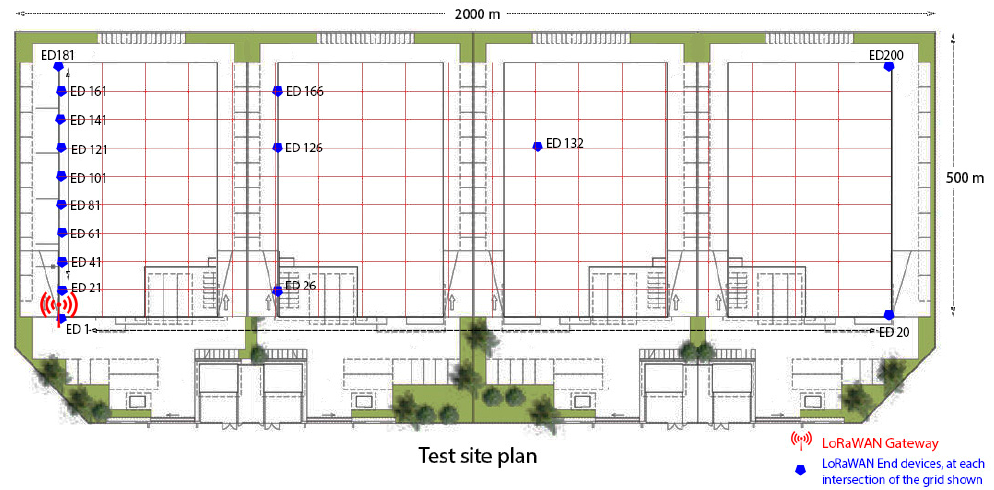
Figure 7. Distribution of nodes within the scenario.